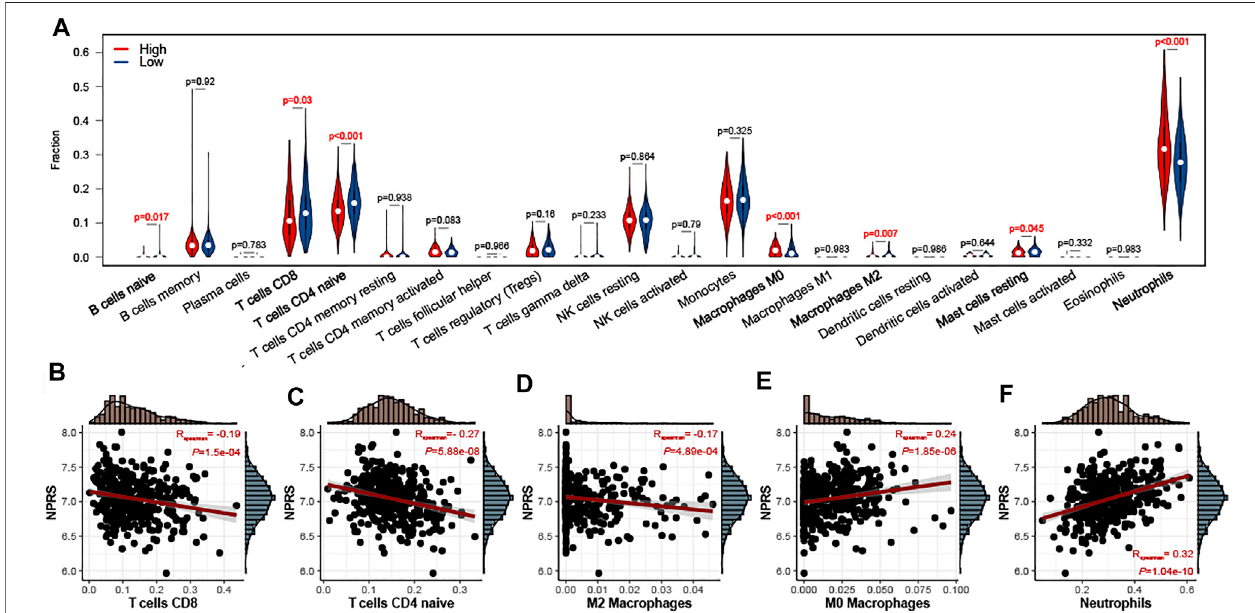
FIGURE 6 | Estimation of peripheral immune cell in fi ltration by the prognostic signature (A) The peripheral in fi ltrating levels in the high- and low- NPRS groups by using CIBERSORT algorithms. The violin plot showed the differences in peripheral immune in fi ltration score between the high- and low- NPRS groups (B-F) The Spearman correlation between NPRS and the fraction of peripheral immune cells is shown. Scatterplots depicts that NPRS is negatively correlated with CD8 T cells (B), CD4 naive T cells (C), and M2 macrophages (D), while positively correlated with M0 macrophages (E) and neutrophils (F) .